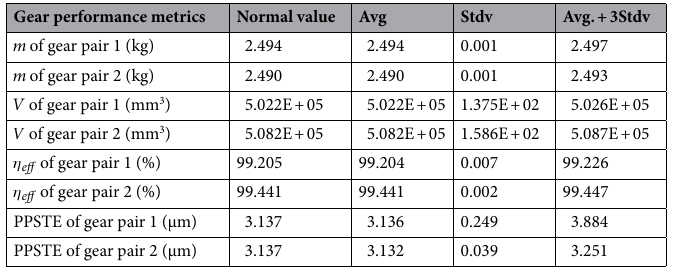
Table 6. Robust analysis results of mass, volume, efficiency, and PPSTE of each gear pair.